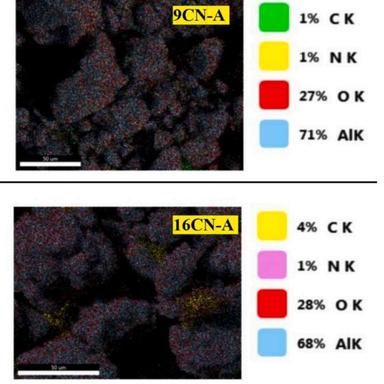
EDAX Elemental Mapping data of CN-A samples with various loadings: 9CN-A & 16CN-A.